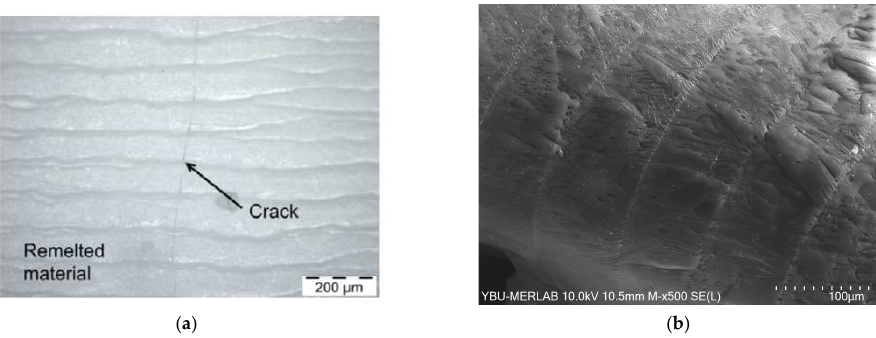
Figure 17. ( a ) SEM micrograph of the alumina–zirconia sample printed using the preheating system developed by Yves-Christian et al. [36]. ( b ) SEM micrograph of the alumina sample (A) printed using the preheating system developed in this study.